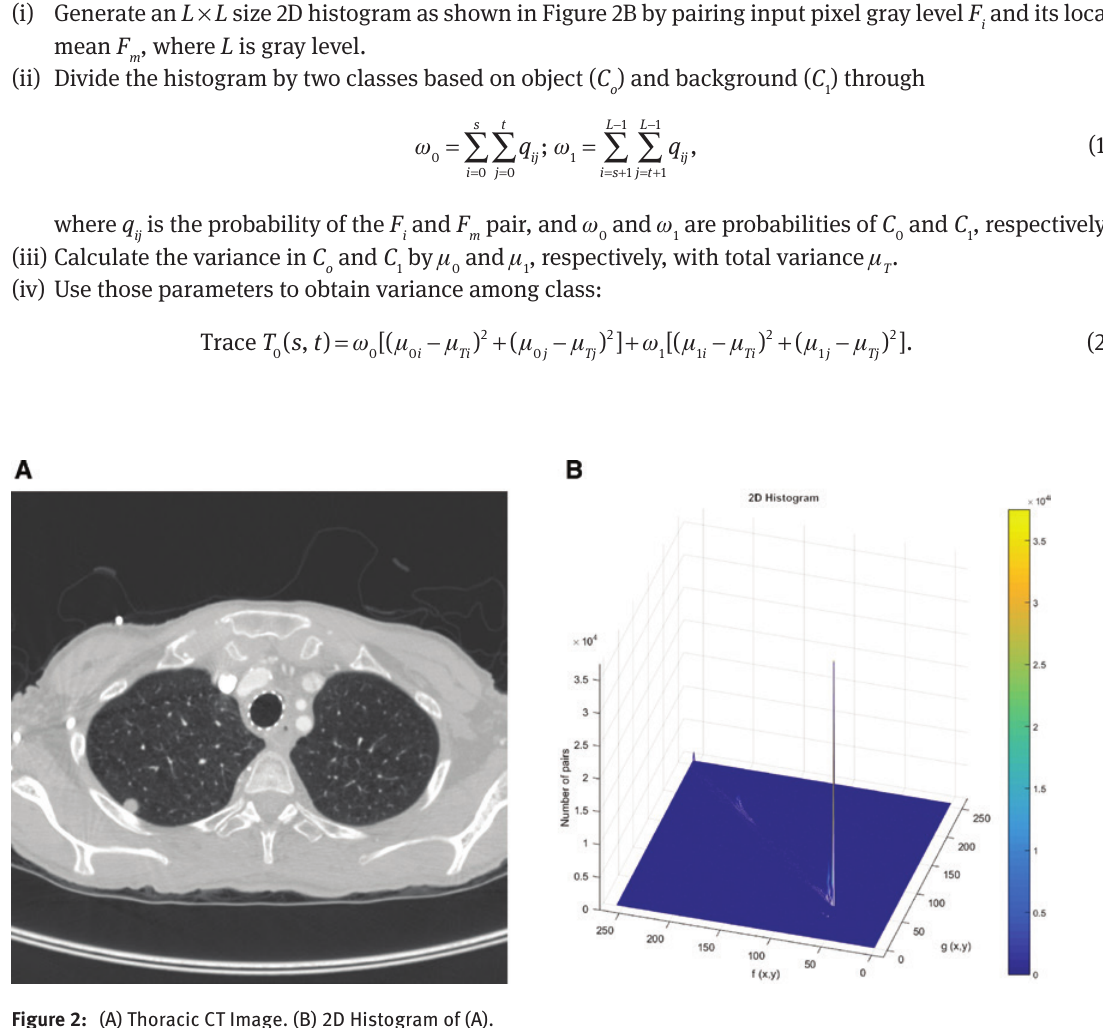
Figure 2: (A) Thoracic CT Image. (B) 2D Histogram of